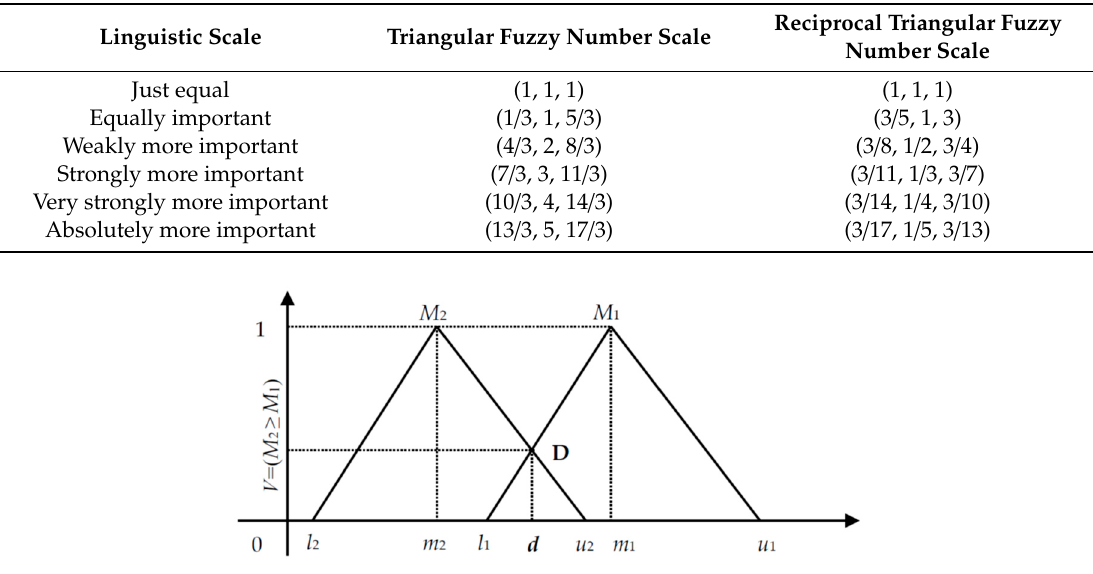
Table 1. Triangular fuzzy number conversion scale [87].